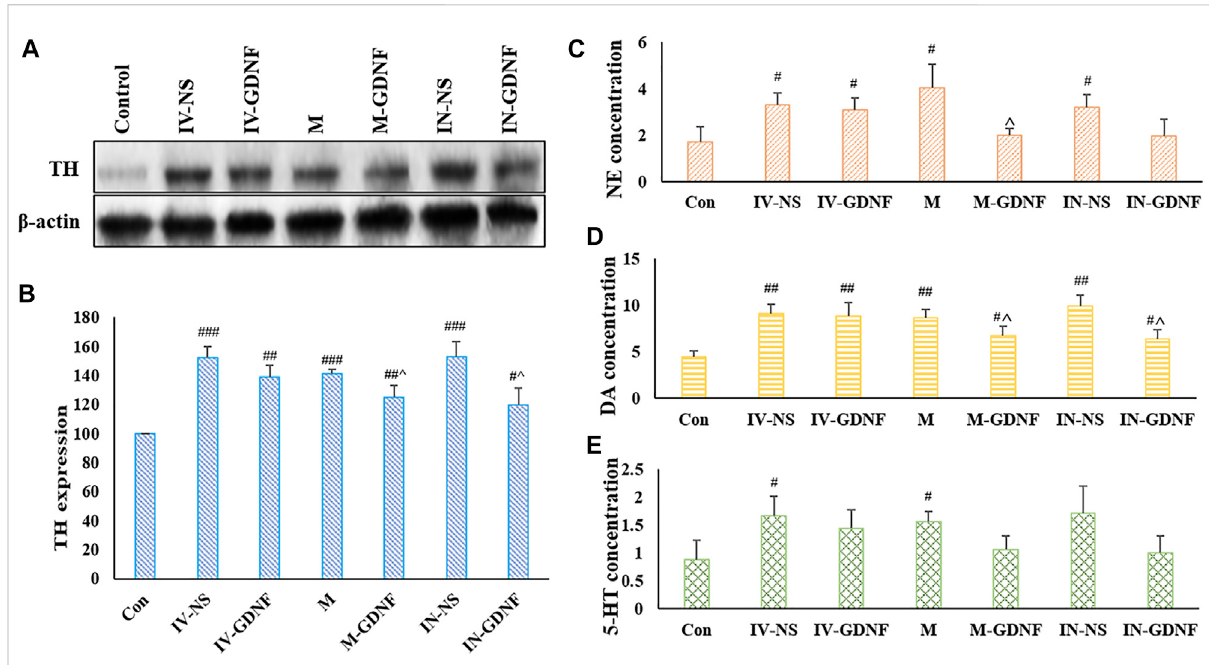
FIGURE 5 Effect of different treatments on neurotransmitters of morphine withdrawal rats. (A) Representative bands of TH expression. (B) Analysis of TH expressionindifferentgroups. (C) NEconcentrationmeasuredbyHPLC. (D) DAconcentrationmeasuredbyHPLC. (E) 5-HTconcentrationmeasured by HPLC. Means ± SEM, n = 3, # p < 0.05, ## p < 0.01, ### p < 0.001 vs . Control group; ^ p < 0.05 vs . IV-SN group. DA, dopamine; HPLC, high performance liquid chromatography; 5-HT, serotonin; NE, norepinephrine; TH, tyrosine